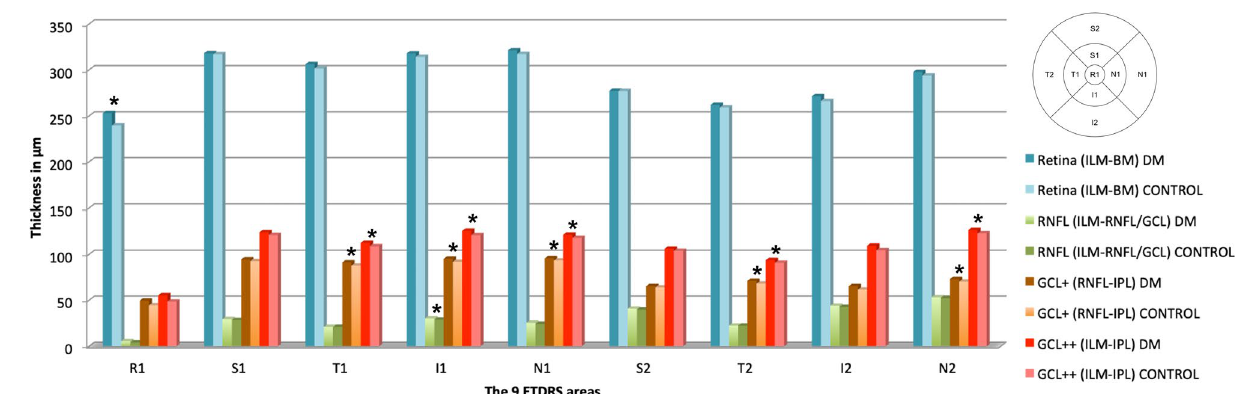
Figure 4. DRI Triton SS-OCT. Mean thickness per ETDRS area is in μm, and statistical significance with p < 0.05 is marked with * of the total retina (from the ILM to the BM), RNFL (from the ILM to the RNFL), GCL+ (from the RNFL to the IPL) and GCL++ (from the ILM to the IPL) in the diabetic group and in the control group. DM Diabetes mellitus, ETDRS Early Treatment of Diabetic Retinopathy Study, RNFL Retinal nerve fiber layer, GCL Ganglion cell layer, BM Bruch membrane, ILM Inner limiting membrane, IPL Inner plexiform layer, R1 Central, S Superior, T Temporal, I Inferior, N Nasal, 1 corresponds to the values of the 3 mm parafoveal inner circle, and 2 corresponds to the values of the 6 mm peripheral outer